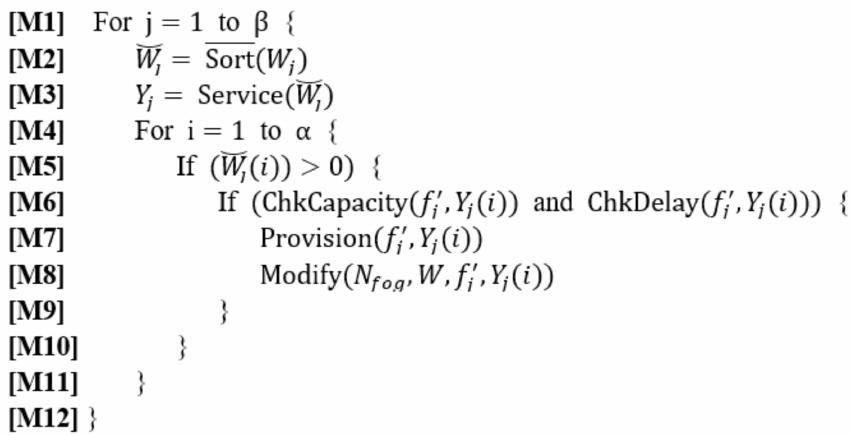
Figure 2. The procedure of the maximal coverage-SP (MC-SP)